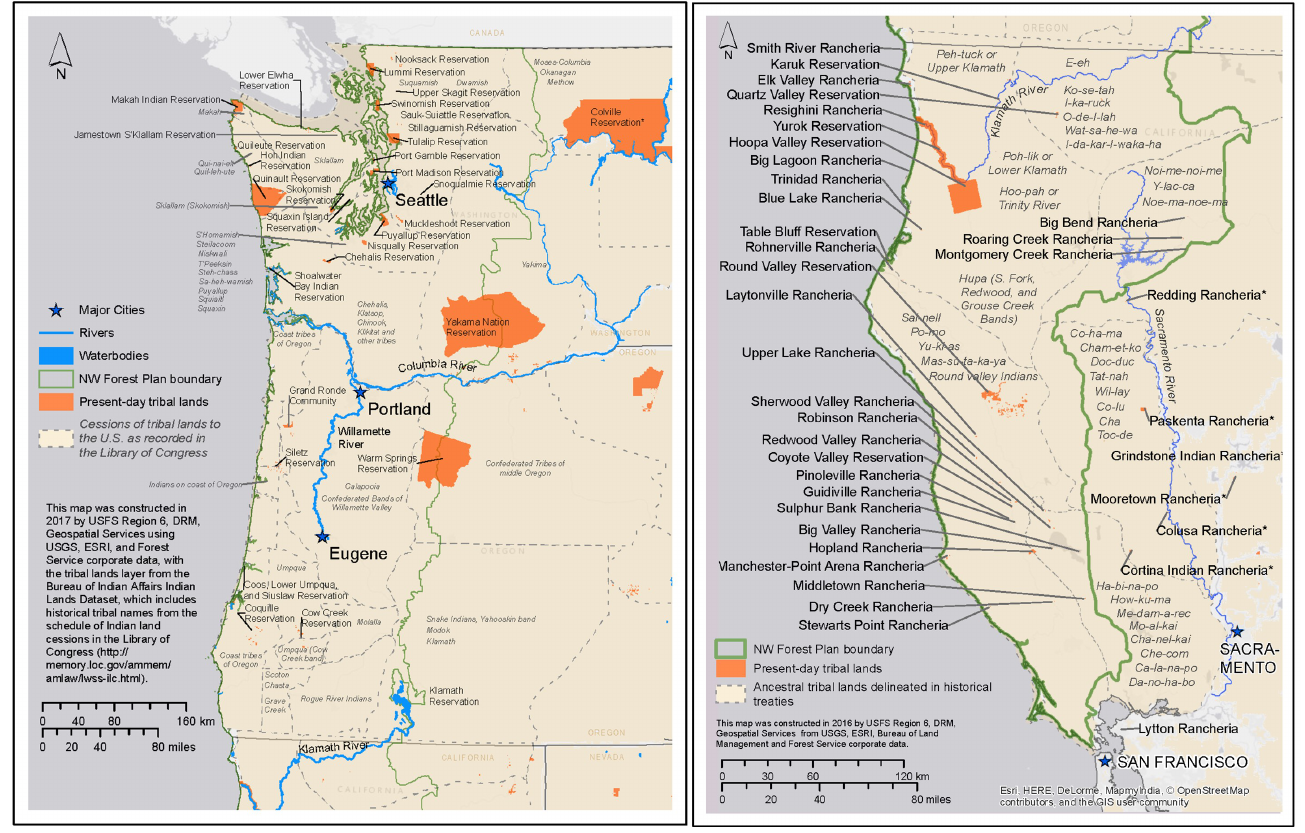
Fig. 1. Present-day tribal reservations, and ancestral lands mapped as cessions to the U.S. Government in Library of Congress records (https://memory.loc.gov/ammem/amlaw/lwss-ilc.html) within the Northwest Forest Plan area in Washington and Oregon (left), and northern California (right), USA. Asterisks denote tribal lands outside the boundary belonging to tribes that have ancestral lands within the